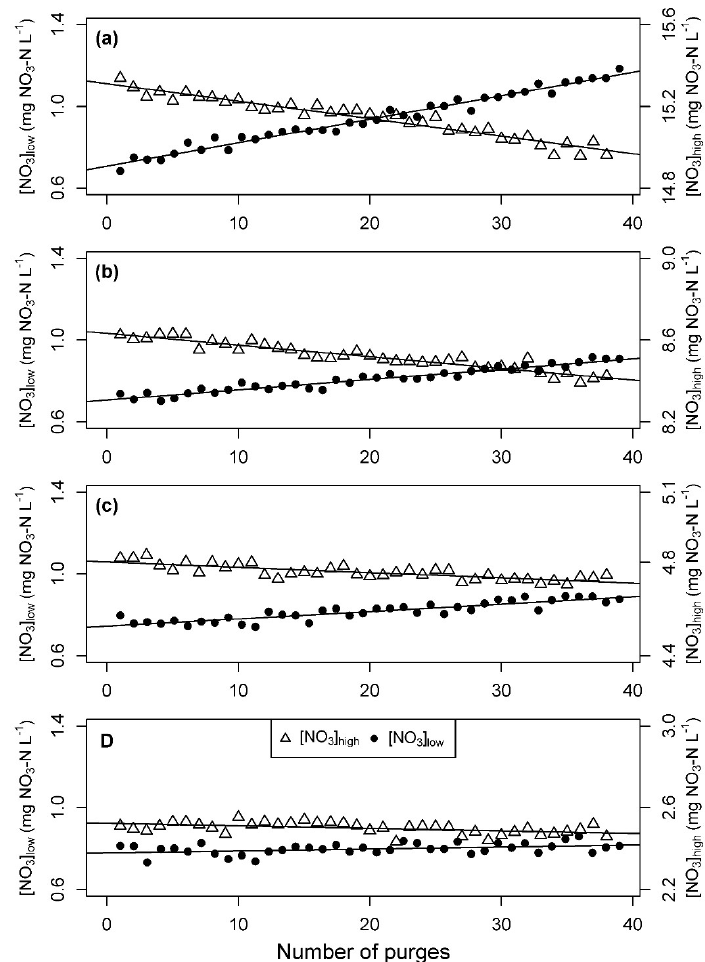
Figure 2. Changes in NO − concentrations in low ( [ NO 3 ] low ) and high ( [ NO 3 ] high ) concentration sources (0.5L) resulting from residual 3 volumes purged to the alternate source. Greater concentration or dilution effects were seen with increasing differences in initial NO − concentrations of the sources during trials (a) – (d) .